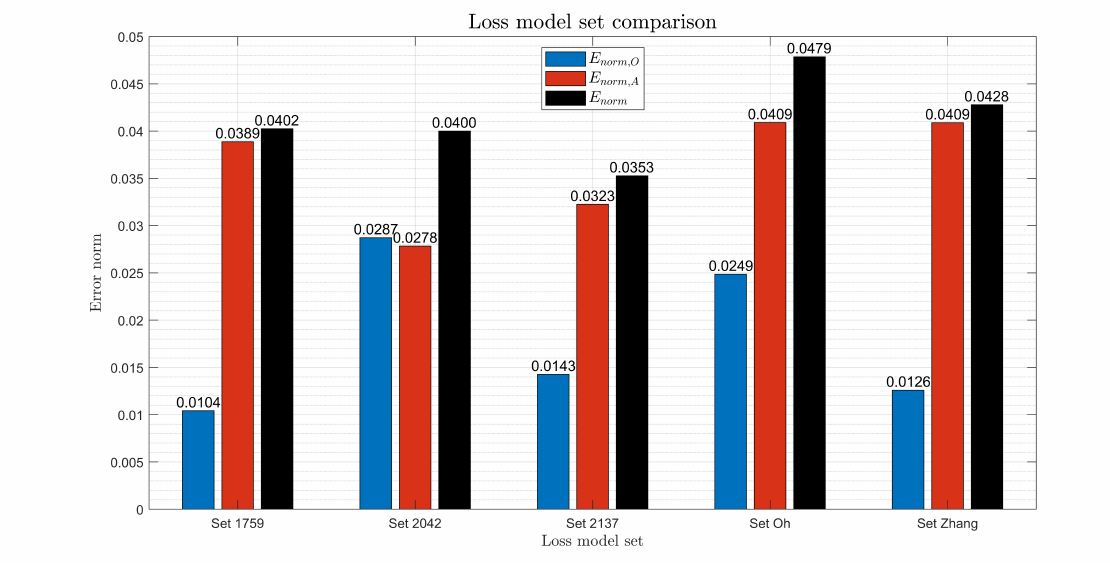
Figure 8. Bar graph of error norms for candidate loss model sets. Error evaluation is defined by Equations (61) and (62).